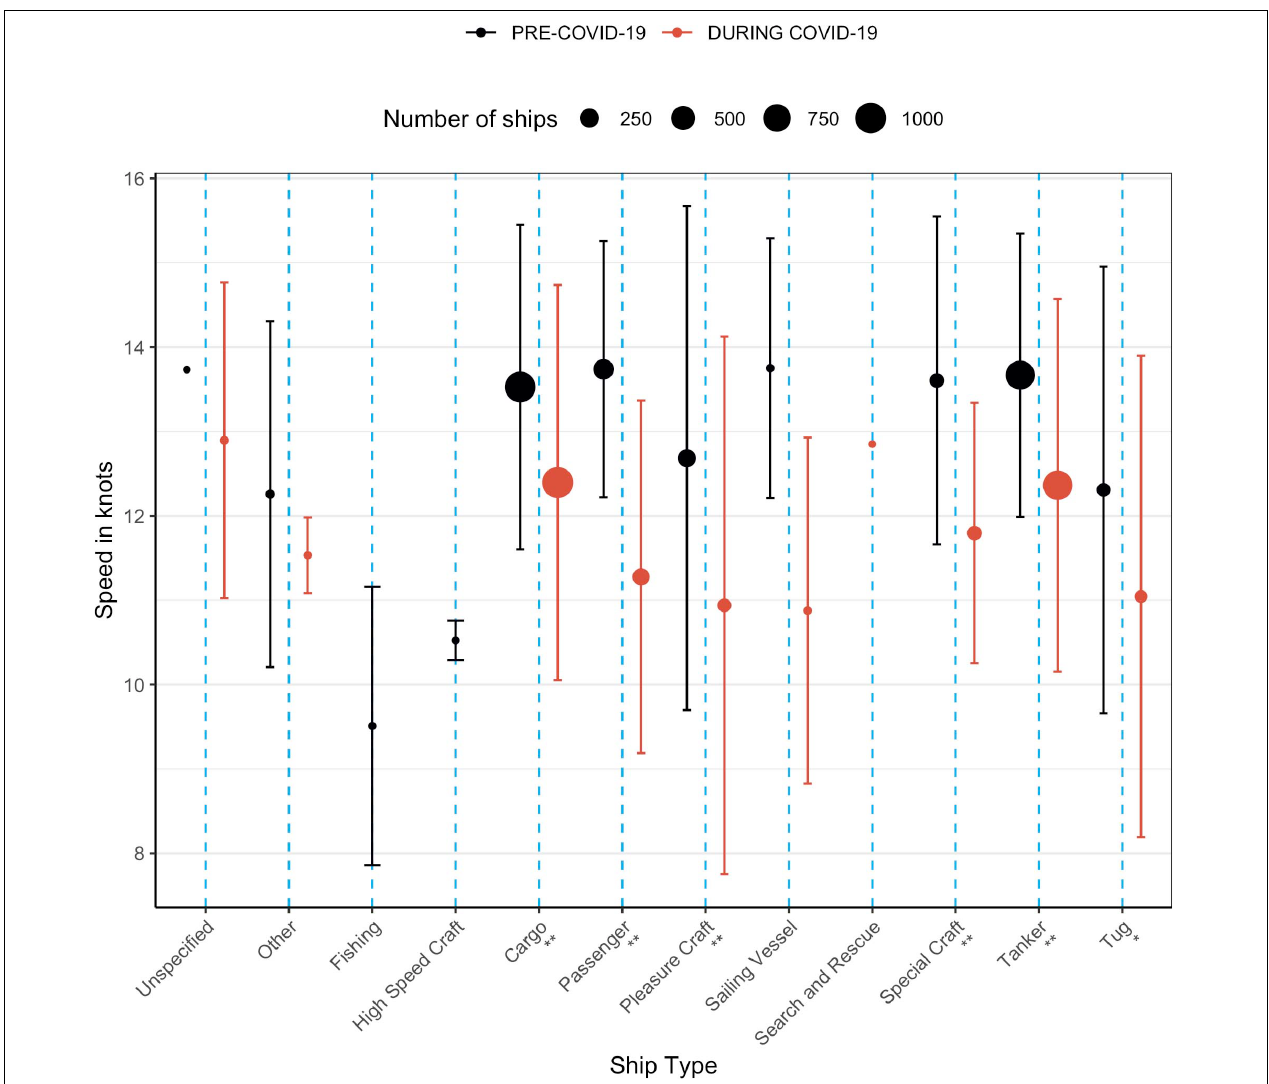
FIGURE 4 | Speed by ship type, pre- and during COVID-19, with the size of the point scaled to represent the number of ships, error bars representing the standard deviation of the mean speeds and the p -value of the t -test between datasets (* p < 0.05; ** p < 0.01) for each ship type. Sample sizes were not large enough for Unspecified and Other ships to be included. The ship type “Special Craft” is made up of a variety of types (e.g., fire fighting vessels, supply vessels and landing